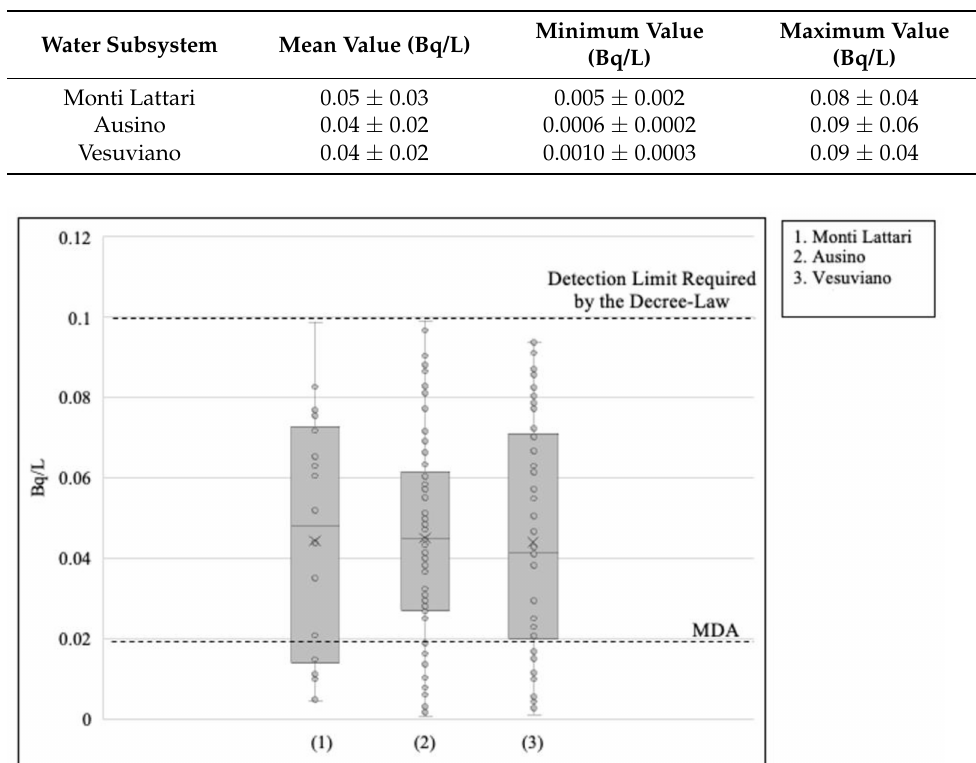
Figure 2. Variability of alpha activity concentration of the water subsystems. The graph reports median, 25th, and 75th percentile. Additionally, two horizontal lines represent the value of the MDA equal to 0.02 Bq/L and the detection limit required by the Decree-Law equal to 0.10 Bq/L.